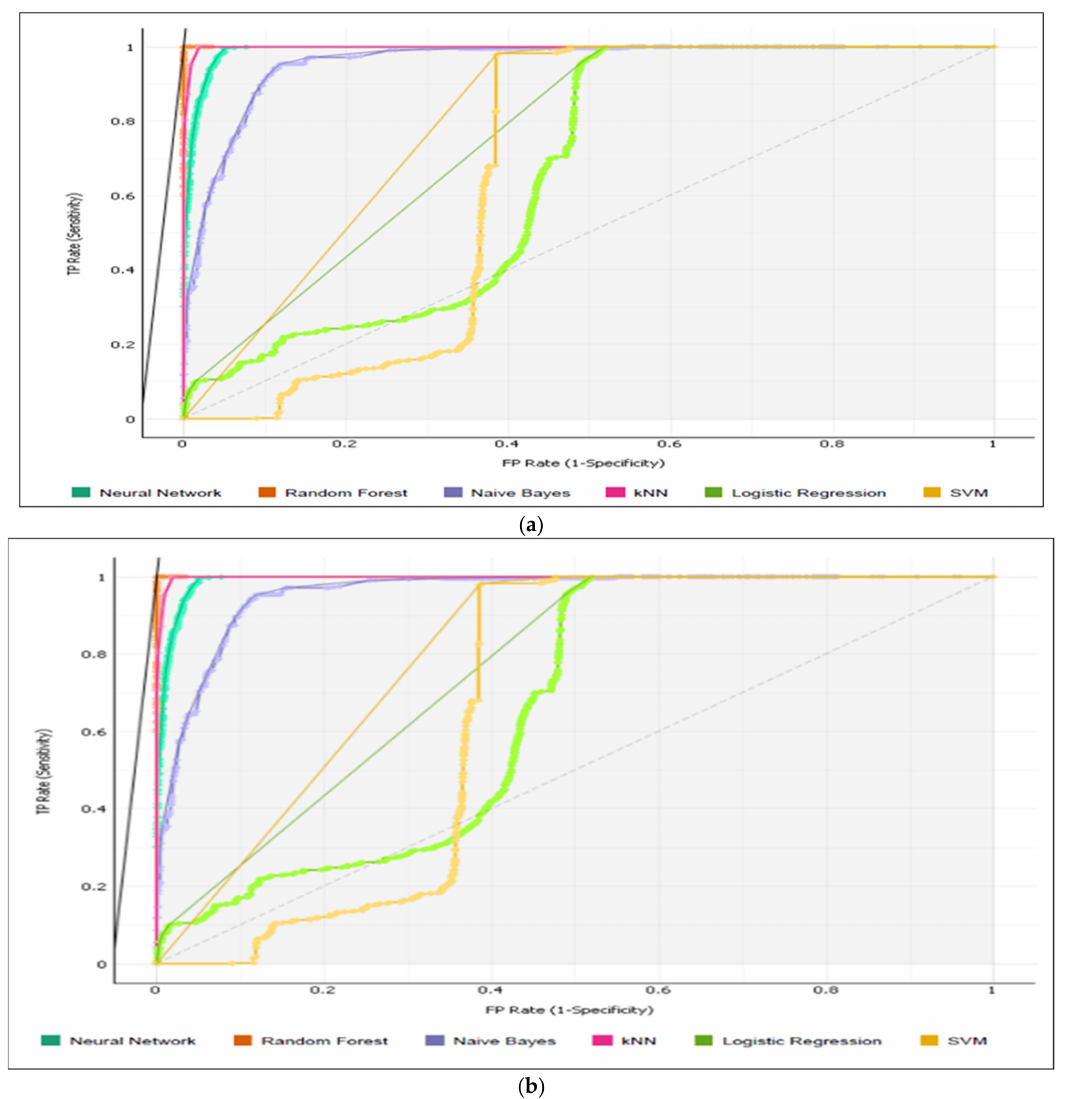
Figure 6. Receiver operating characteristic (ROC) curve for demonstrating the significance of the proposed method with various ML classifiers: ( a ) Amazon echo, ( b ) Belkin motion